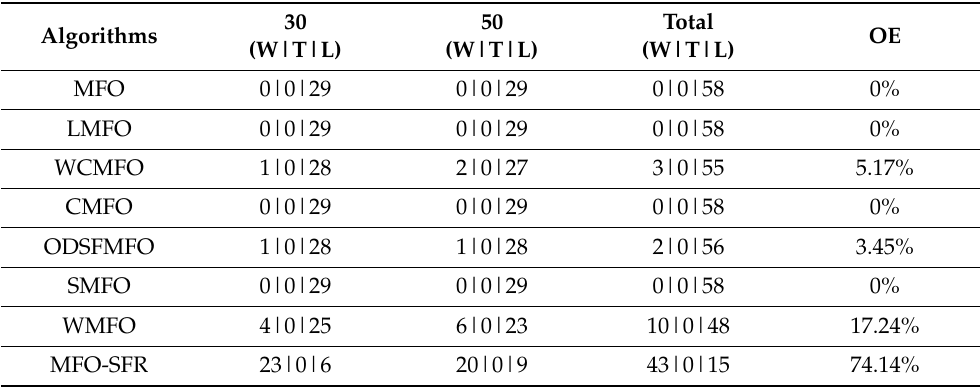
Table 7. The overall effectiveness of MFO-SFR and MFO